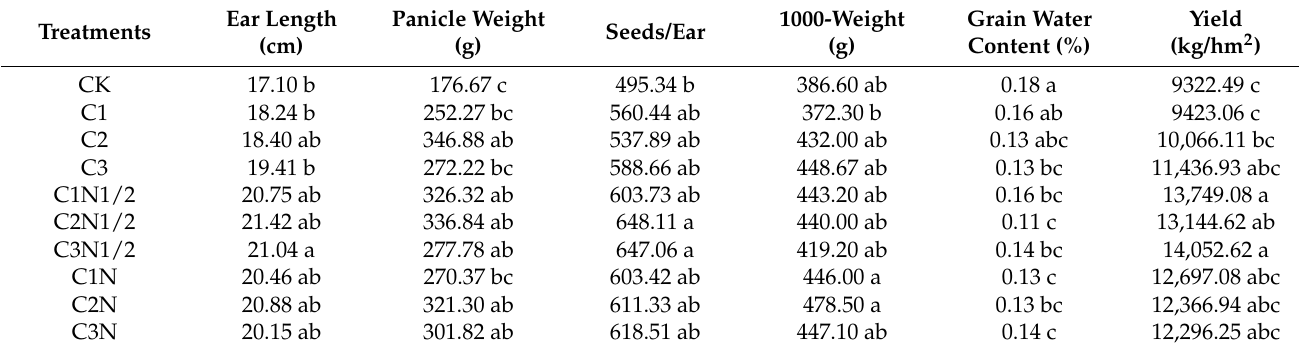
Table 4. Agronomic traits of wheat under different treatments.